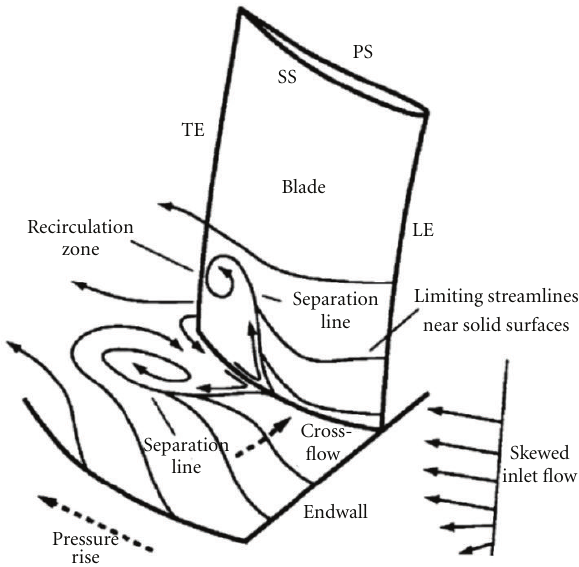
Figure 9: Hub-corner stall-limiting streamlines and separation lines (Lei et al.